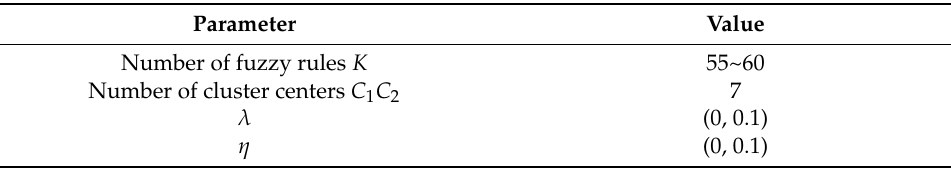
Table 3. Experimental parameter settings.